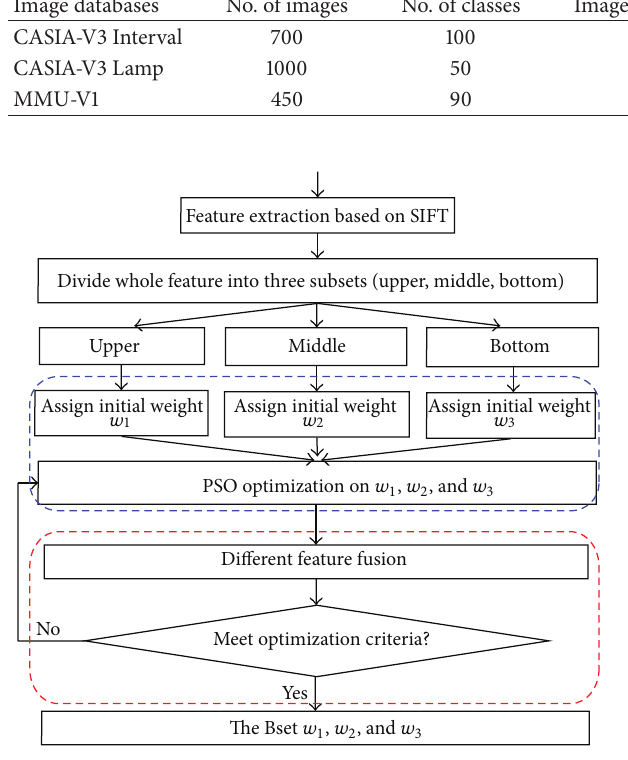
Figure 11: Block diagram for the process of weights assign with